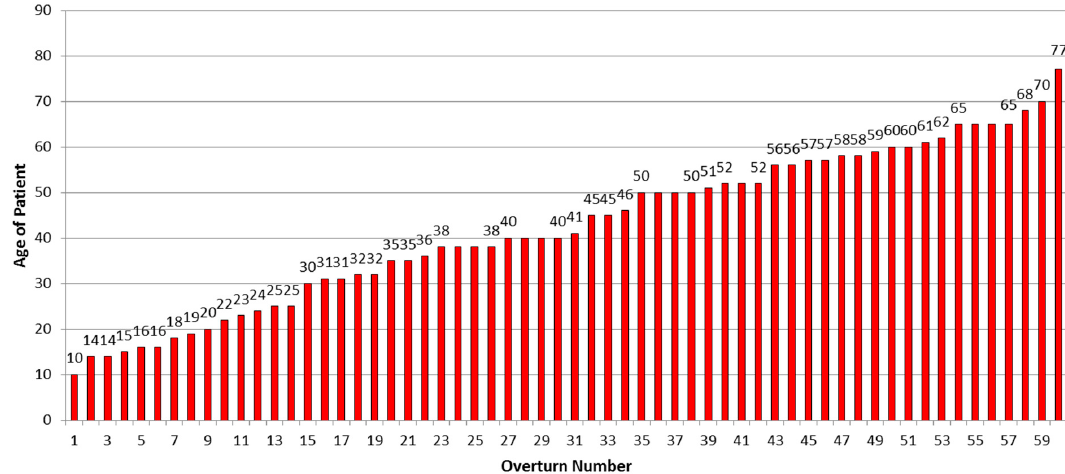
Figure 6. Age of seriously injured operator in an overturns of non-ROPS tractors in Kentucky, 1960–2002, n = 60.